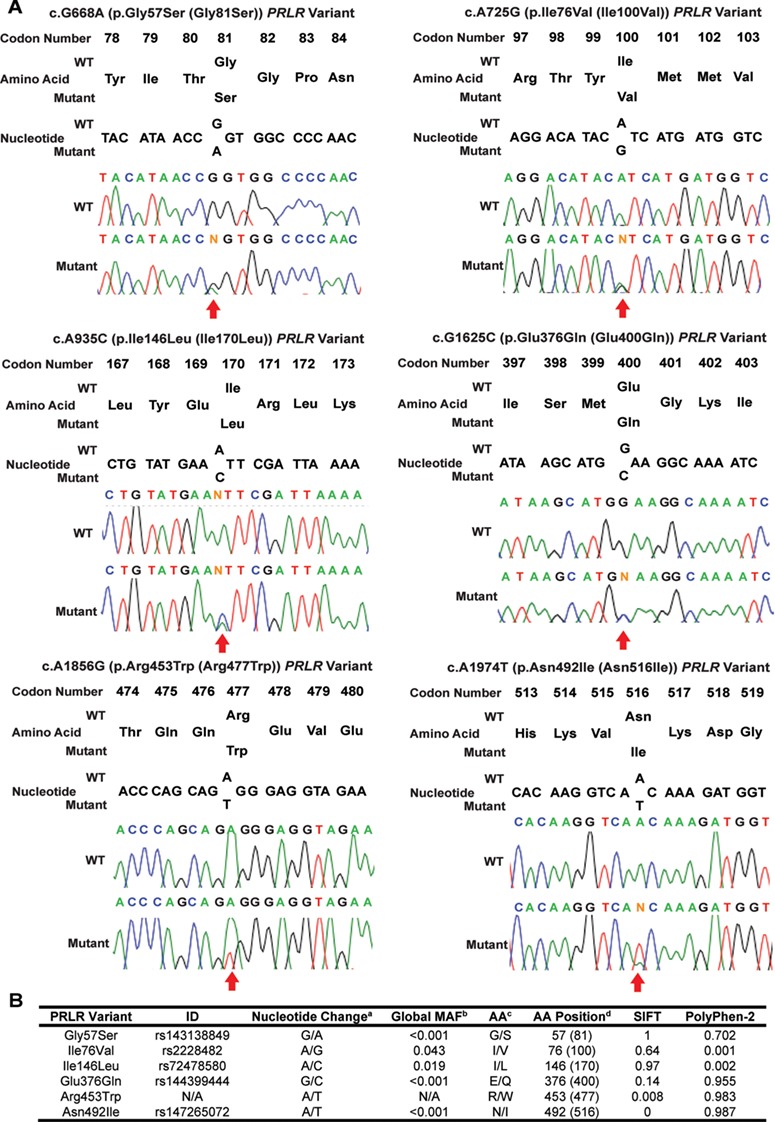
Identification of PRLR variants in prolactinoma patients. (A) DNA sequence analysis in 46 prolactinoma patients identified six PRLR variants. These included three ECD variants: Gly57Ser (upper left panel), Ile76Val (upper right panel) and Ile146Leu (middle left panel); and three ICD variants: Glu376Gln (middle right panel), Arg453Trp (lower left panel) and Asn492Ile (lower right panel). Amino acid and nucleotide numbering is shown above chromatograms. For each chromatogram, codon numbers include the 24 amino acid signal peptide. The Arg453Trp variant has not previously been reported in online databases. Each chromatogram is from leucocyte DNA. (B) Global MAF and pathogenicity prediction of the six PRLR variants. aReference allele/minor allele; bMAF of all ethnic groups combined; cAmino acid represented by reference allele/amino acid represented by minor allele; and dAmino acid number in mature protein without the signal peptide, and with the amino acid number according to the full-length 622 amino acid PRLR protein (NCBI, NP_000940; UniProt P16471) in parentheses. Rare, low-frequency and common variants are defined to have a MAF of <1%, 1–5% and >5%, respectively (30). SIFT and Polyphen-2 scores predict the effect of amino acid substitutions (52,53). SIFT predicts effects based on sequence homology and physicochemical properties and gives a qualitative (either tolerated or deleterious) and quantitative score (probability that the change is tolerated, i.e. the nearer to 0 the more likely deleterious, and the nearer to 1 the more likely benign) (53). Polyphen-2 predicts effects based on sequence homology, protein databank structures and protein family annotations (52). Polyphen-2 gives a qualitative score of probably damaging, possibly damaging, benign or unknown, and quantitative scores are based on the probability that the change is damaging, i.e. the nearer to 0 the more benign. A mutation is classified as probably damaging if the score is >0.85, and possibly damaging if the score is >0.15 (52).